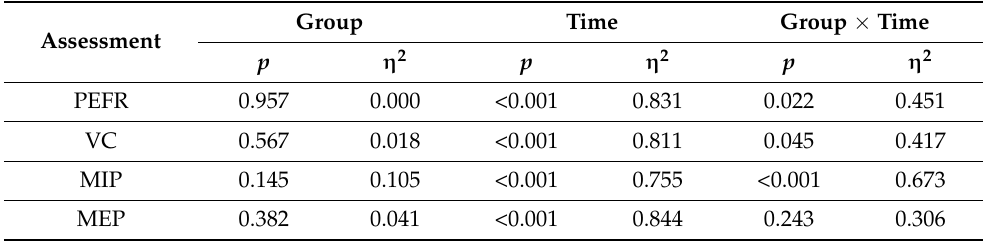
Table 3. Music of model effects in pulmonary